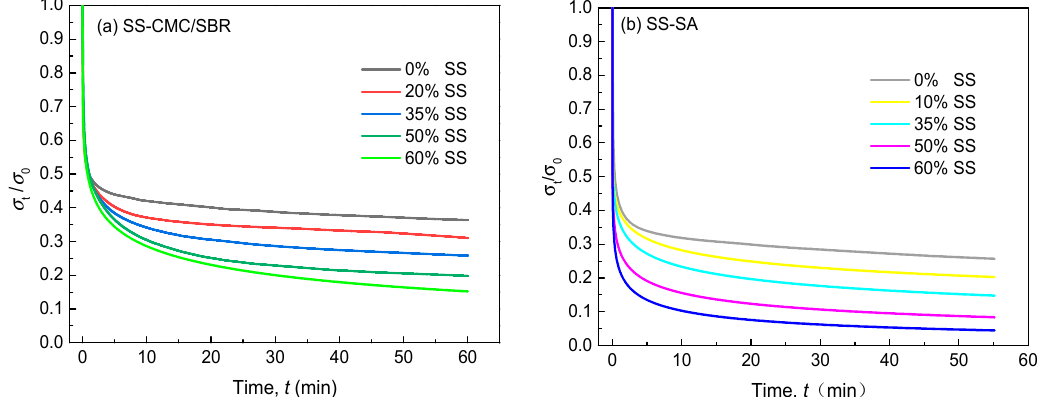
Figure 3. Normalized stress relaxation curves of cured ( a ) SS-SBR / CMC and ( b ) SS-SA films.